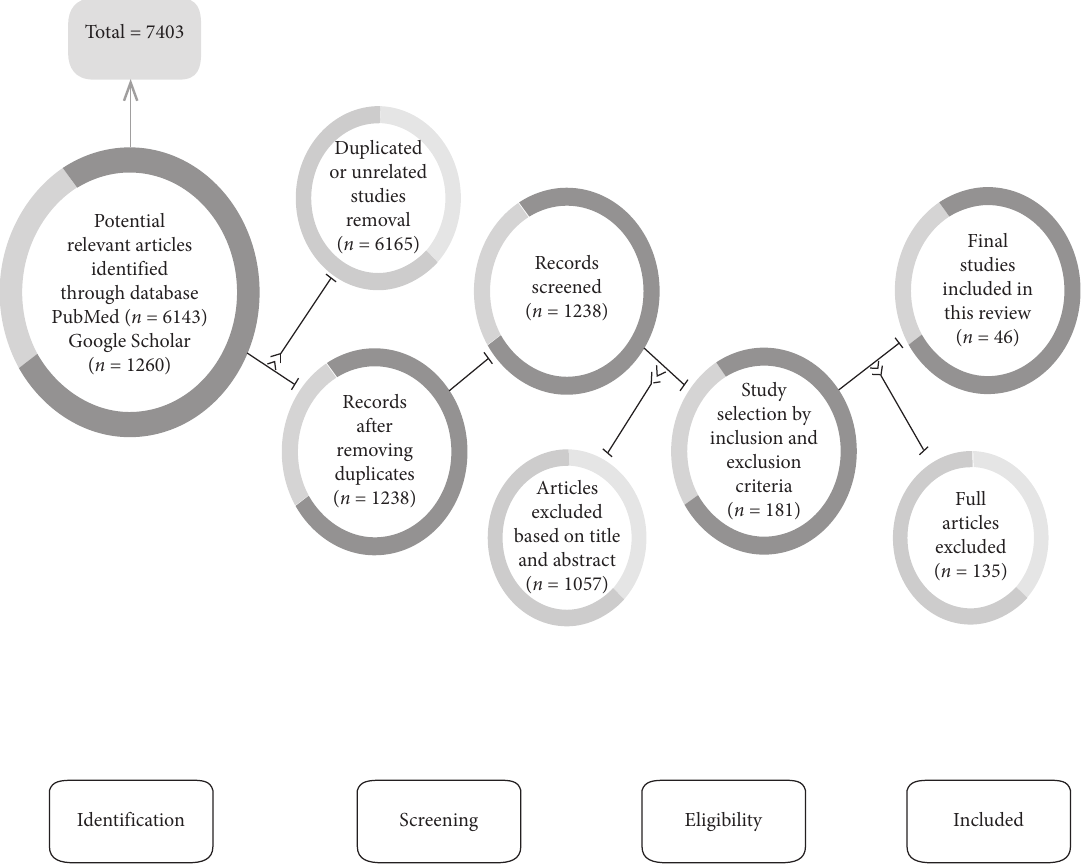
Figure 1: Flowchart outlining the protocol adopted in the systematic review based on the preferred reporting items for systematic reviews and meta-analyses (PRISMA)